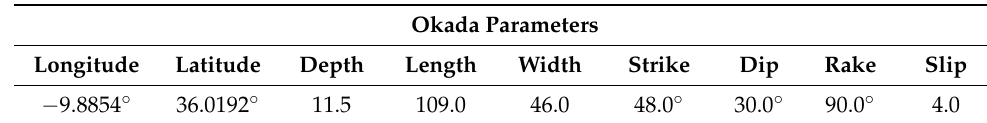
Table 3. Okada parameters for the reference scenario considered. Depth, length, and width are in km, and slip in m.